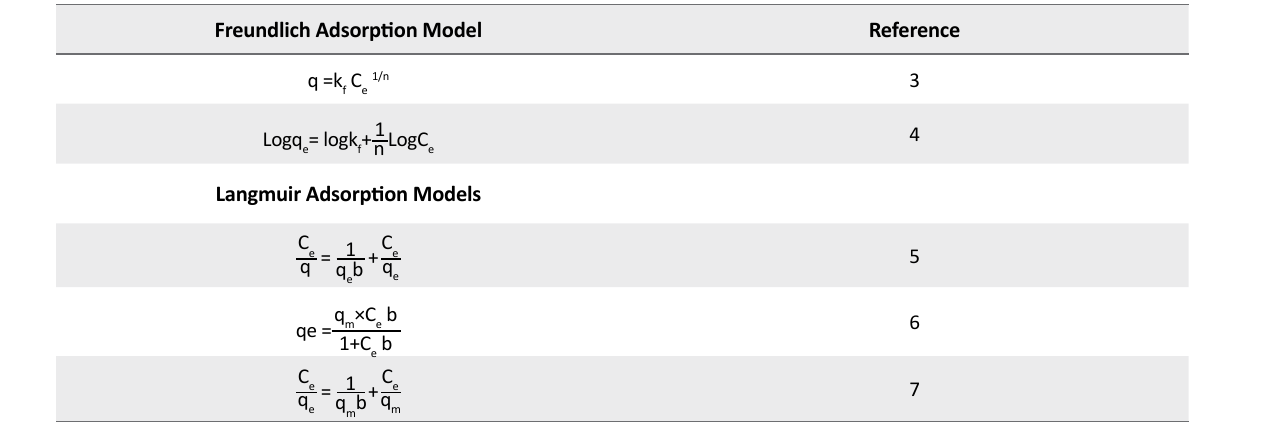
Table 1. Langmuir - freundlich adsorption model